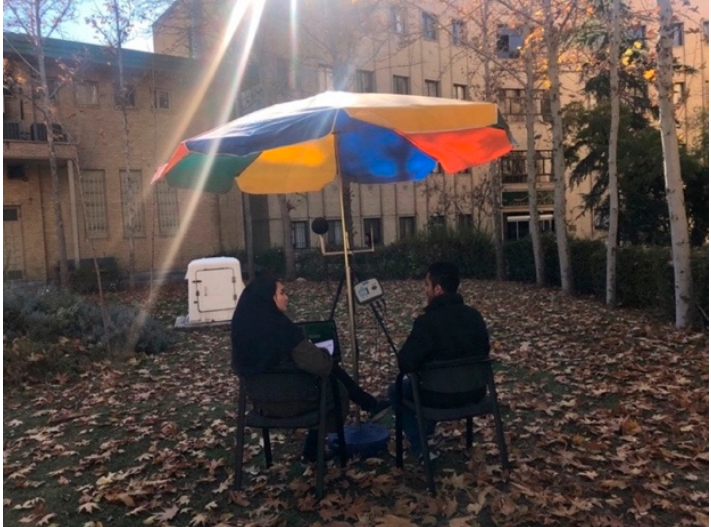
Figure 1. Field survey on the University campus in Tehran; the Delta OHM HD 32.1 data logger was used to record meteorological variables.